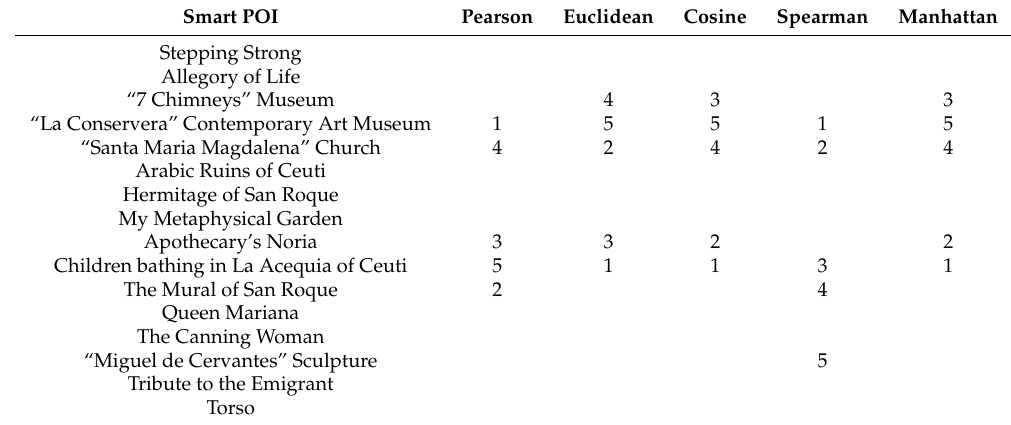
Table 4. Recommendations given by the algorithm to the responder identified by User-CEUTI-1 (I).